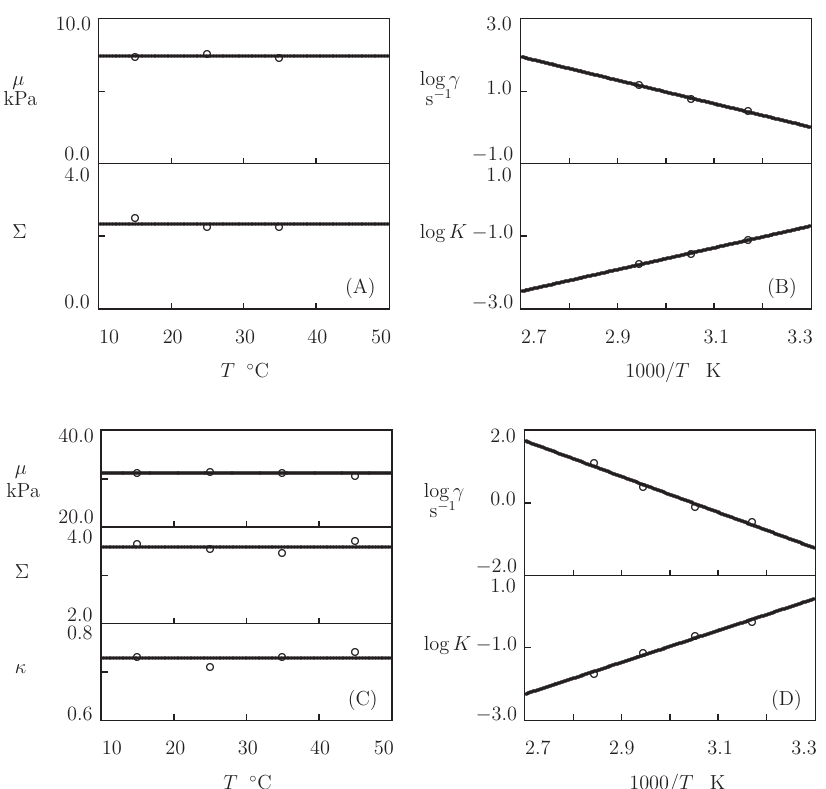
Figure 18. Parameters µ , Σ , κ ( A , C ) and γ , K ( B , D ) versus temperature T . Circles: treatment of observations [74] on o-Cys-P 4 -Cys gels with mass fractions of proteins 0.1 ( A , B ) and 0.2 ( C , D ). Solid lines: the results of